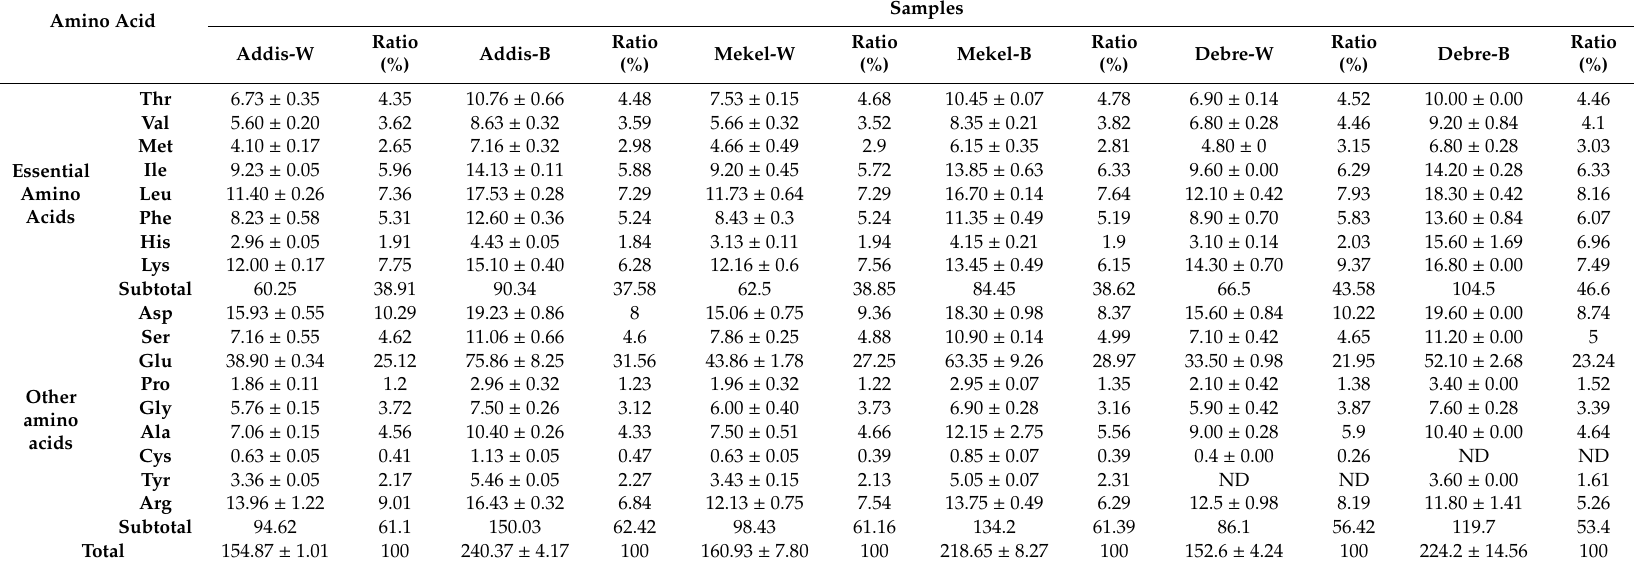
Table 1. Amino acid composition (mg / g flour dry weight) and ratio of individual amino acid (%) of 6 te ff flour